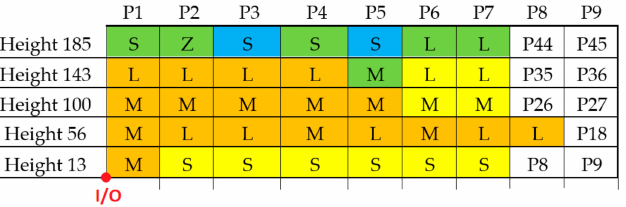
Figure 6. Storage assignment proposal based on minimization of the time-based objective function (scenario 3, short rack).